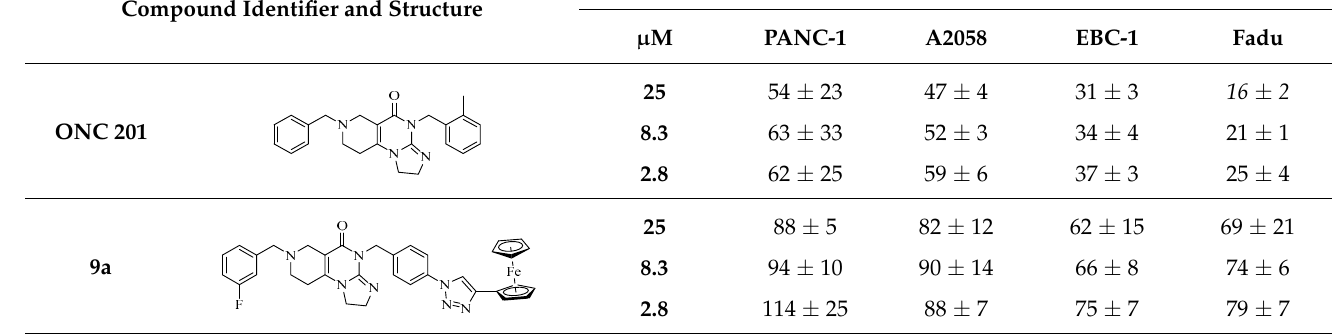
Table 1. Cell viability screening on PANC-1, A2058, EBC-1 and Fadu cell lines. (Data represent the mean ± SD; n = 4). Cell viability data below 10% and in between 10 and 20% are presented in bold and in italics, respectively.